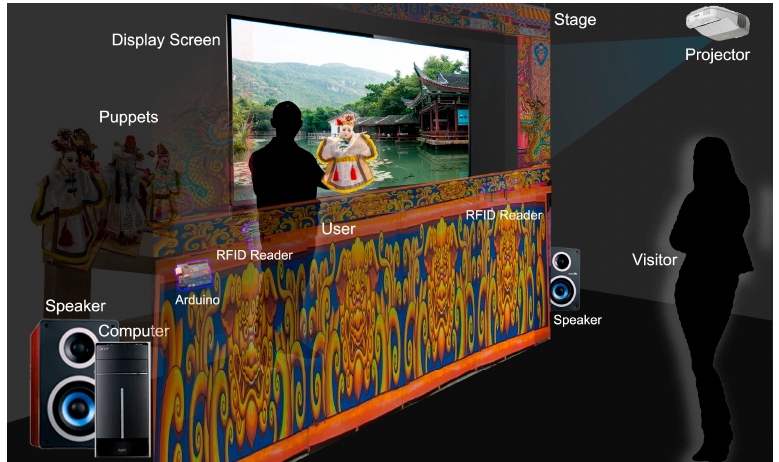
Figure 9. The user of the system is emulating the expert’s performance inside the stage while facing the audience (the visitor) after watching the expert’s performance video as illustrated in Figure 5 (note: the puppet’s face is toward the audience and the screen is showing a static image instead of a dynamic video).